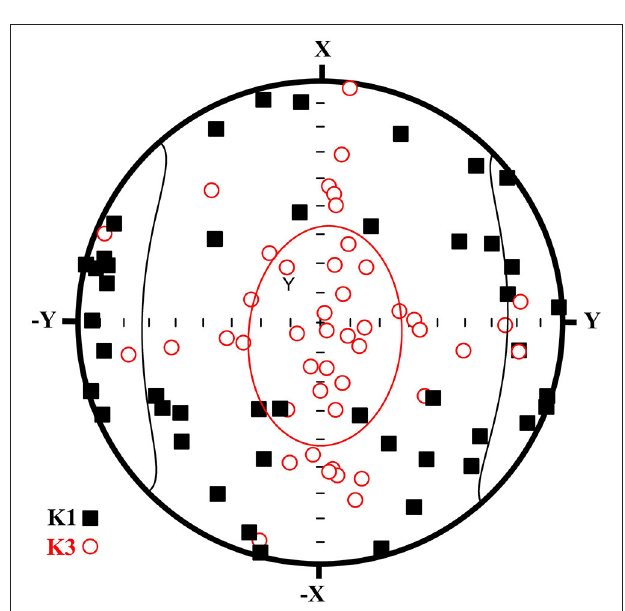
FIGURE 7 | Stereographic projections of maximum (K1) and minimum (K3) susceptibility directions. Each point corresponds to one of the core samples selected for magnetic mineralogy measurements. Thin contours correspond to confidence